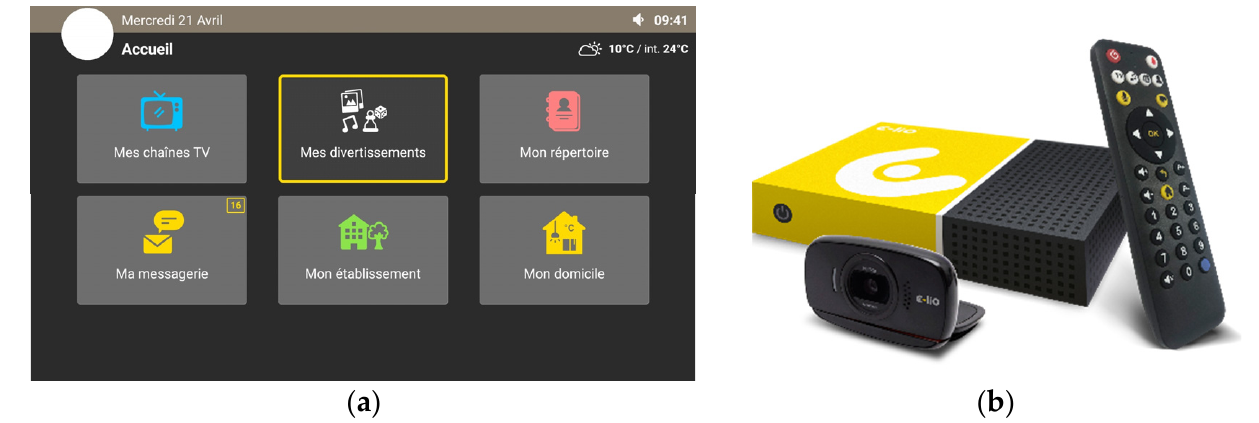
Figure 1. The e-lioTV system: ( a ) TV interface (main menu); ( b ) Box, camera, and remote control.